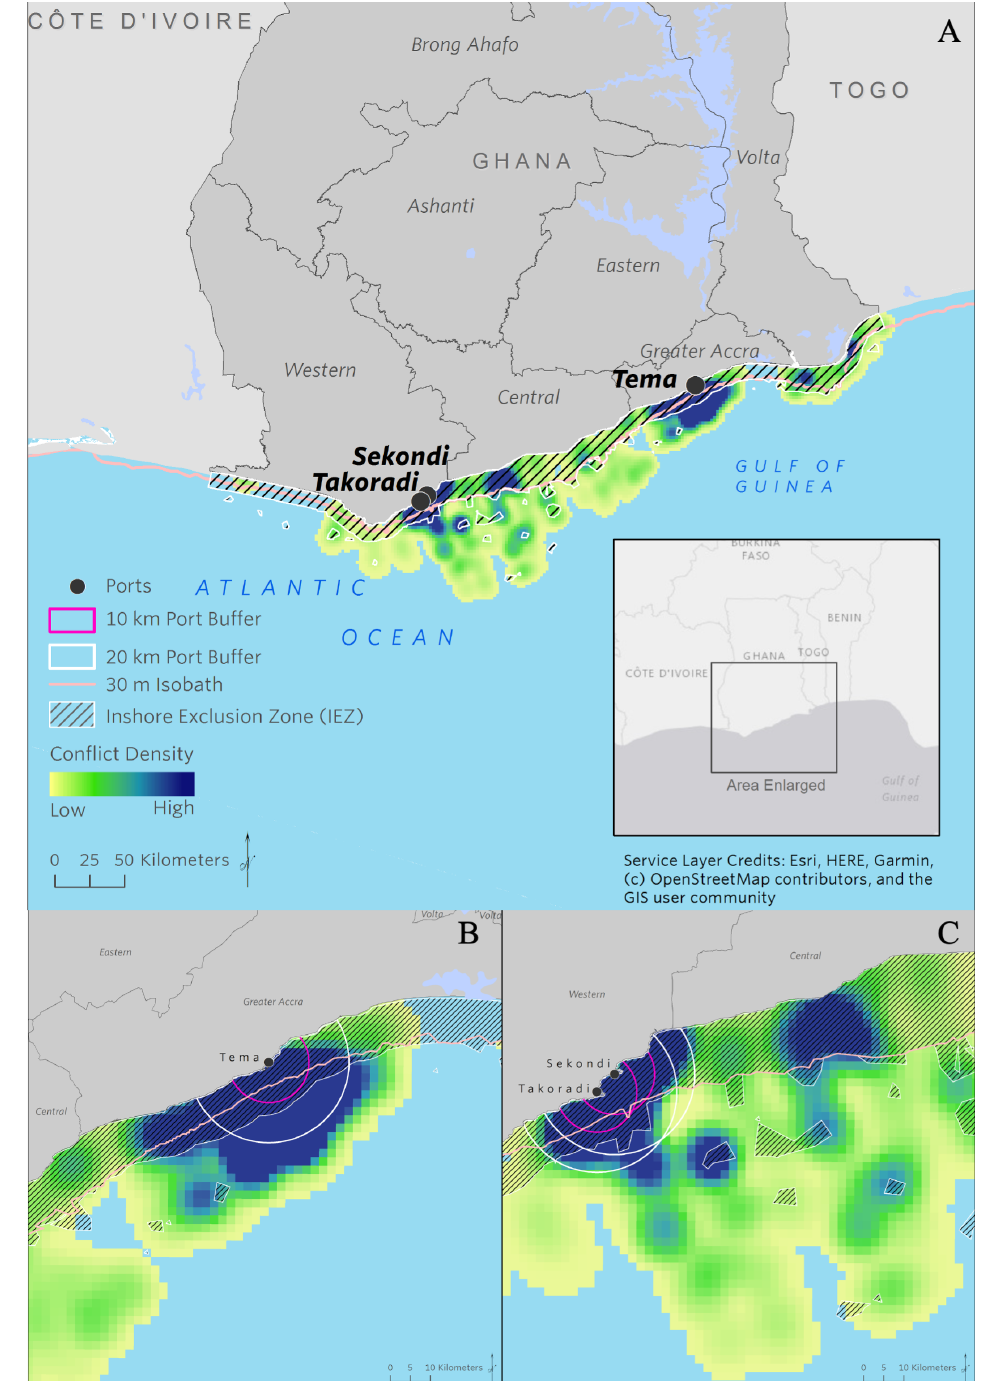
Fig. 1. Predicted spatial patterns of conflict between small-scale and industrial fishing vessels for (A) the entire study region along the coast of Ghana. This predicted conflict density was based on narrative information on conflict location as reported in historical conflict records (1985-2014). Insets show the areas around (B) the Tema port and (C) the Takoradi/Sekondi